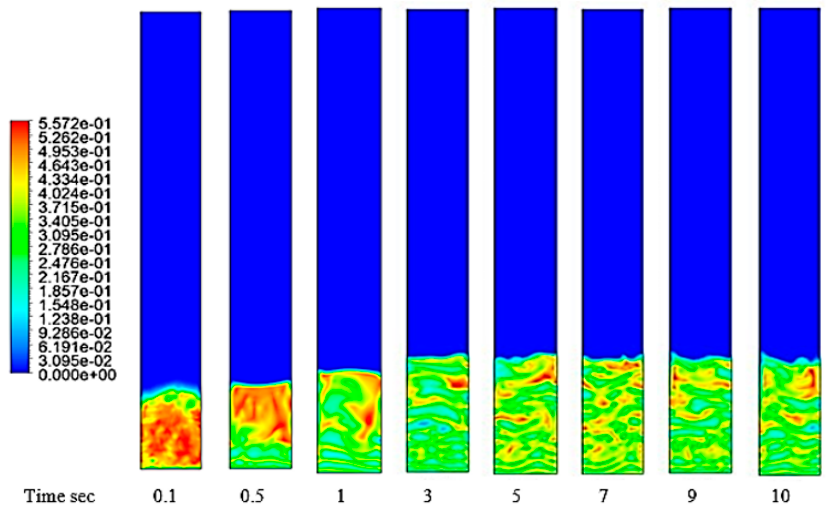
Figure 10. The volume fraction of particles with a diameter of 6 mm with different times.